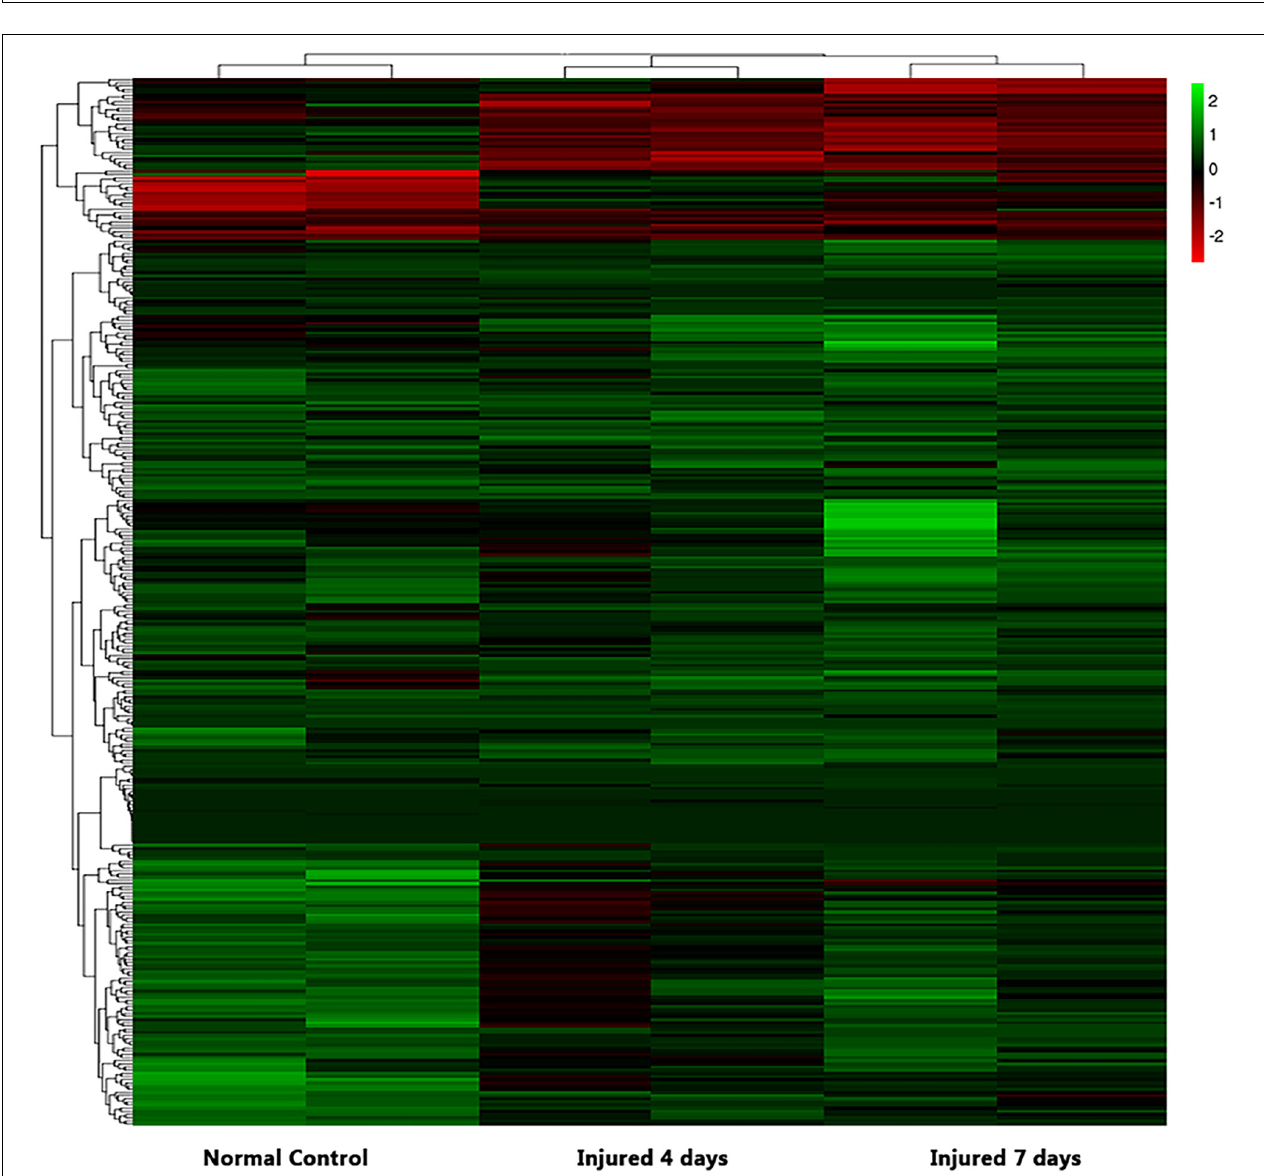
FIGURE 3 | Heatmap of differential mRNA expression after RNA sequencing at different times (4 and 7 days after injury) soon after sciatic nerve contusion in SD rats. Black indicates no significant fold change in mRNA expression between the groups, green indicates increased expression, and red indicates decreased expression.